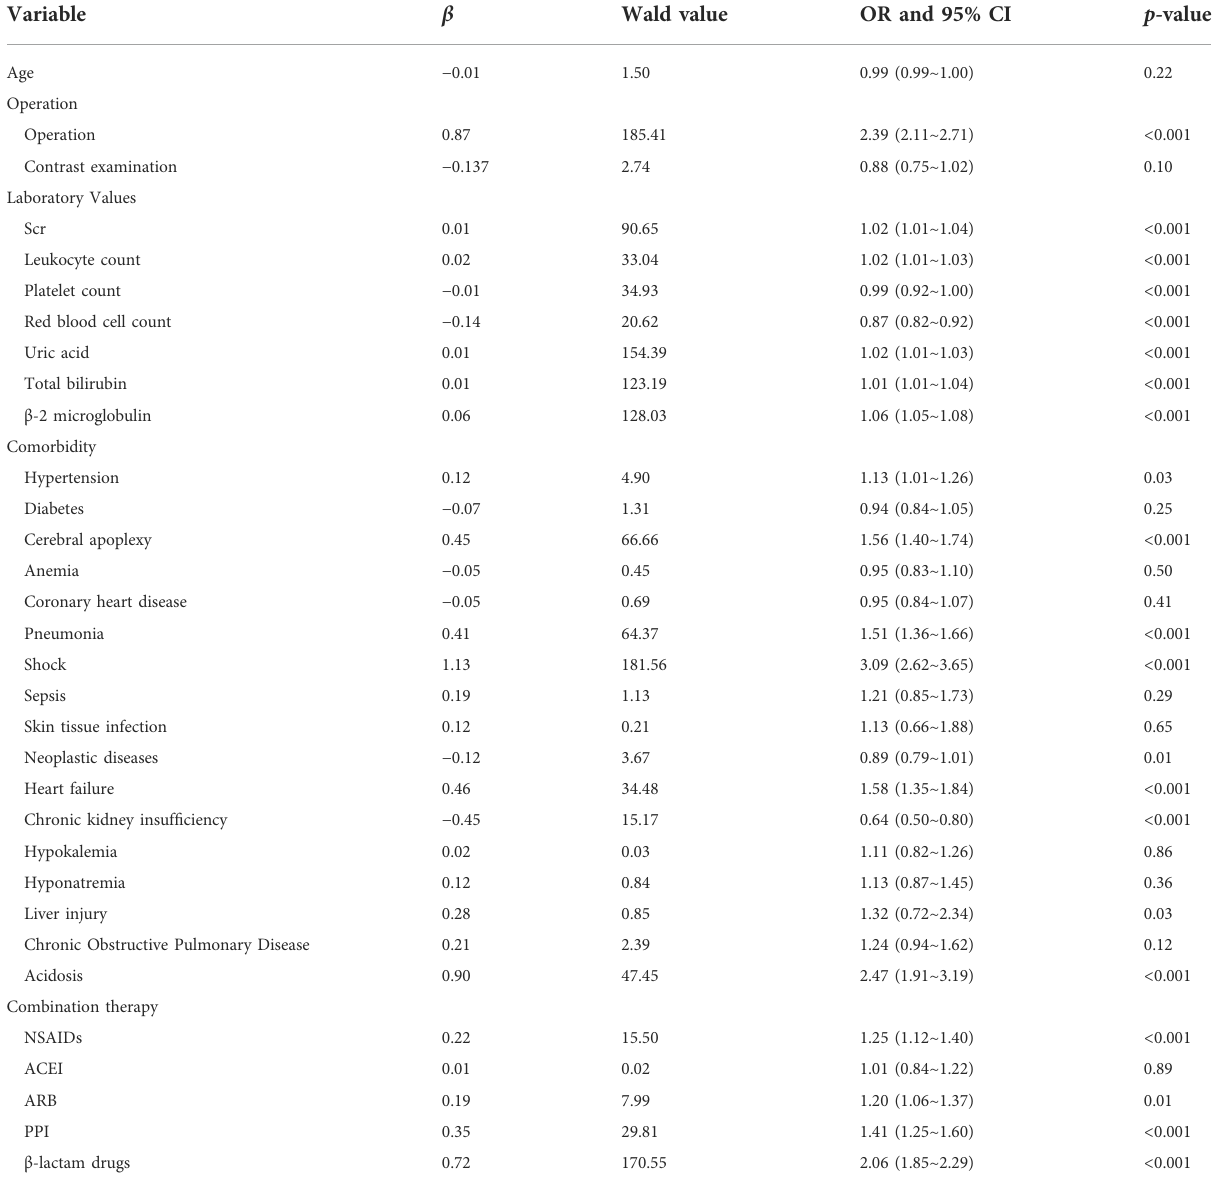
TABLE 4 Multivariate logistic regression analysis of AKI in hospitalized